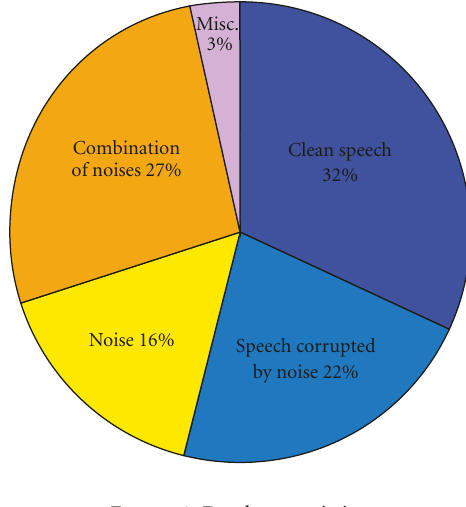
Figure 3: Database statistics.